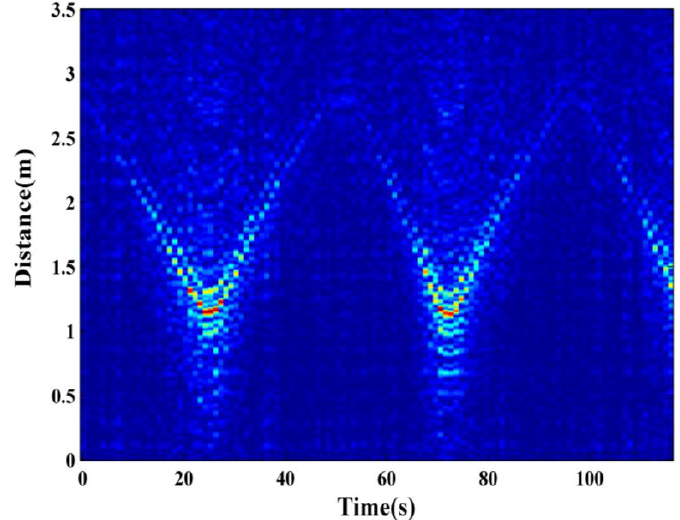
Figure 8. Tracking results of moving subject.